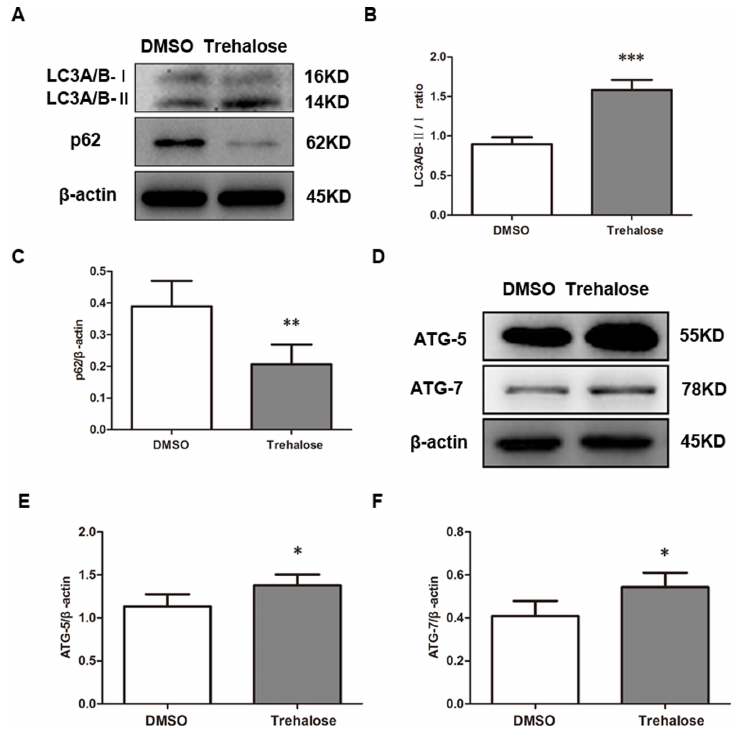
Fig 3. Effect of trehalose on autophagy in cryopreserved valve cells. (B, C, E and F) Western blotting using LC3A/ B-II/I, p62, ATG-5 and ATG-7 antibodies on cryopreserved valve cells treated with trehalose (0.1 mol/L) or DMSO for 16 weeks. Data are expressed as the mean ± SD ( n = 20 per group). (cid:3)(cid:3) P < 0.01, (cid:3)(cid:3)(cid:3) P < 0.001 versus the DMSO group.